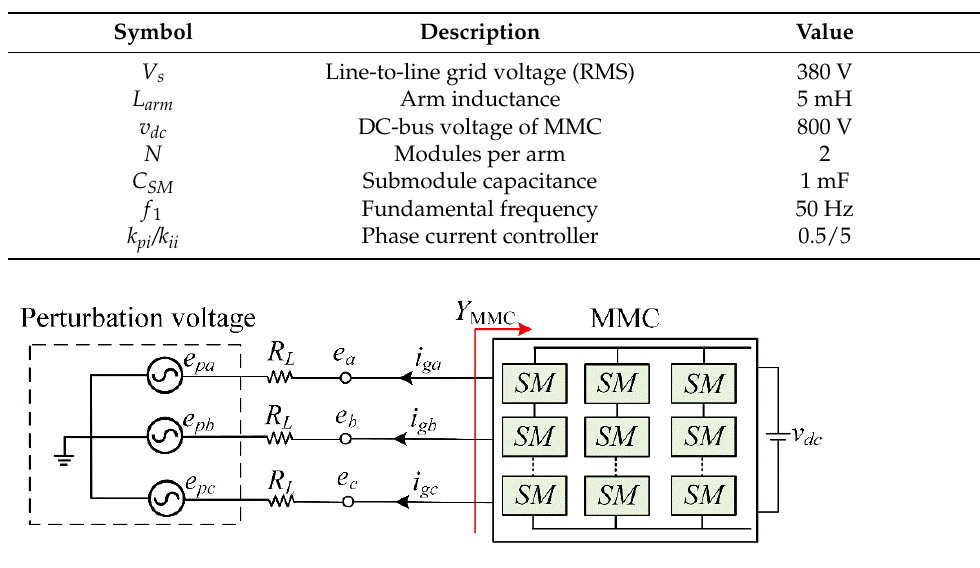
Table 1. Parameters of MMC in the downscaled prototype.